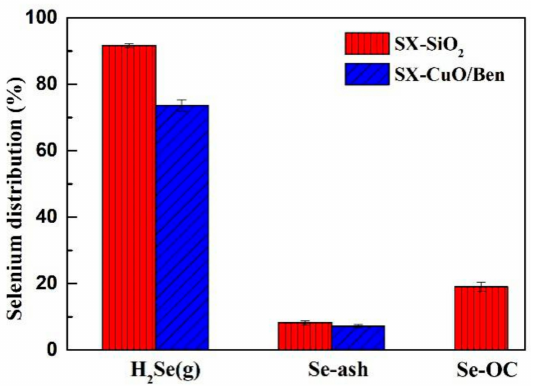
Figure 3. Selenium distribution during coal gasification and